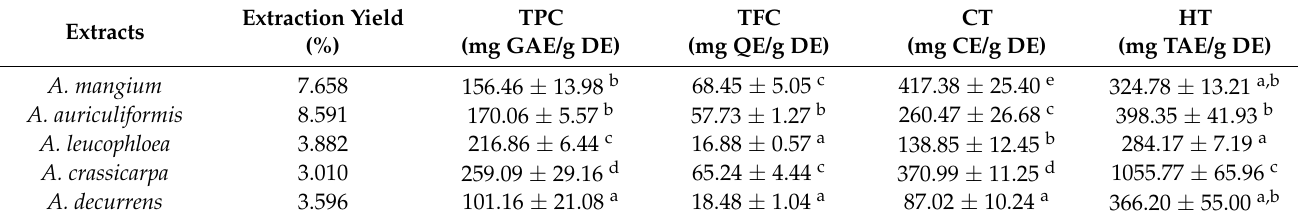
Table 1. The yields and phytochemical profiles of the five Acacia heartwood methanolic extracts. Extraction Extracts